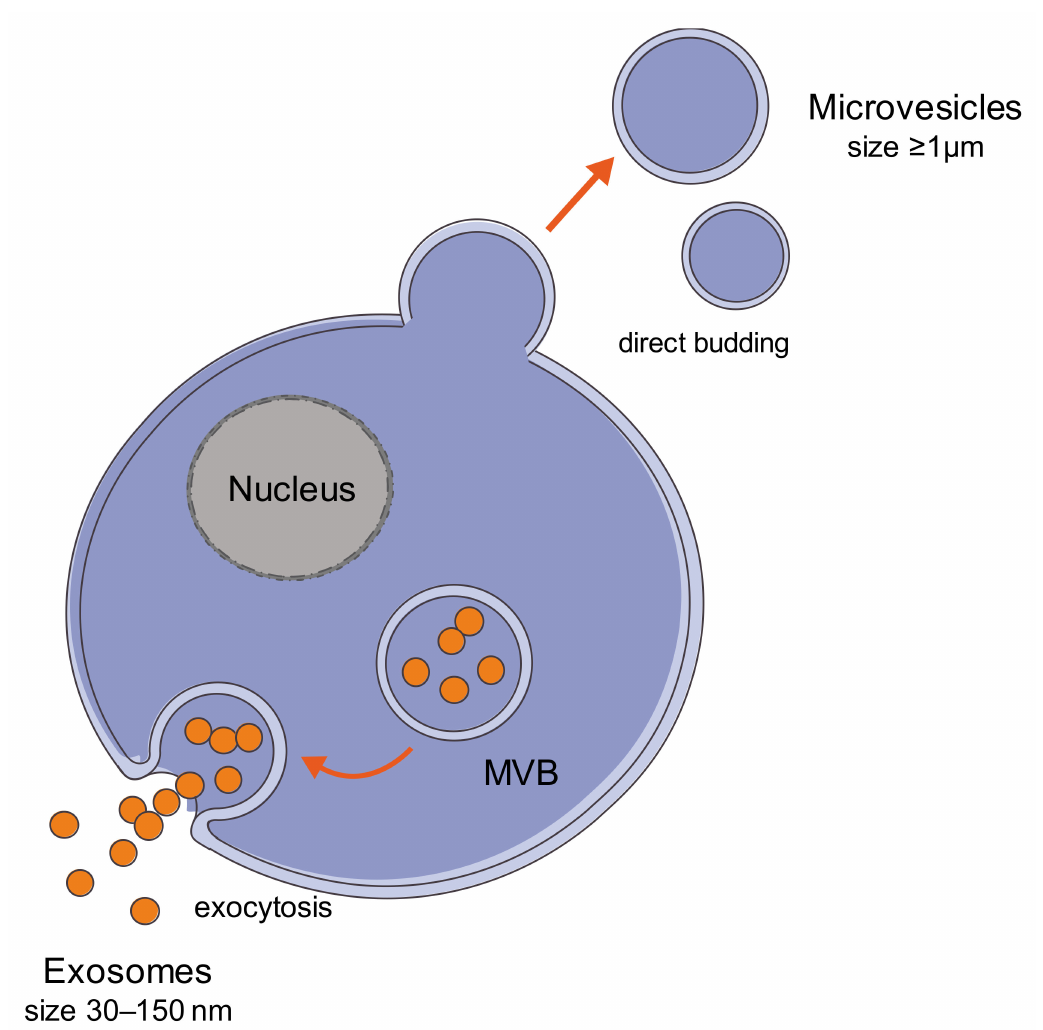
Figure 1. Extracellular vesicles (EVs). EVs represent a heterogeneous population of vesicles, including microvesicles and exosomes, differing in size, content and biogenesis. Microvesicles (up to 1 µ m) are produced by direct outward budding of the cell membrane; exosomes are small vesicles (30–150 nm) and are released by fusion of multivesicular bodies (MVBs) with the plasma membrane into the extracellular space. Figure created using Servier Medical Art (https://smart.servier.com; accessed on 1 October